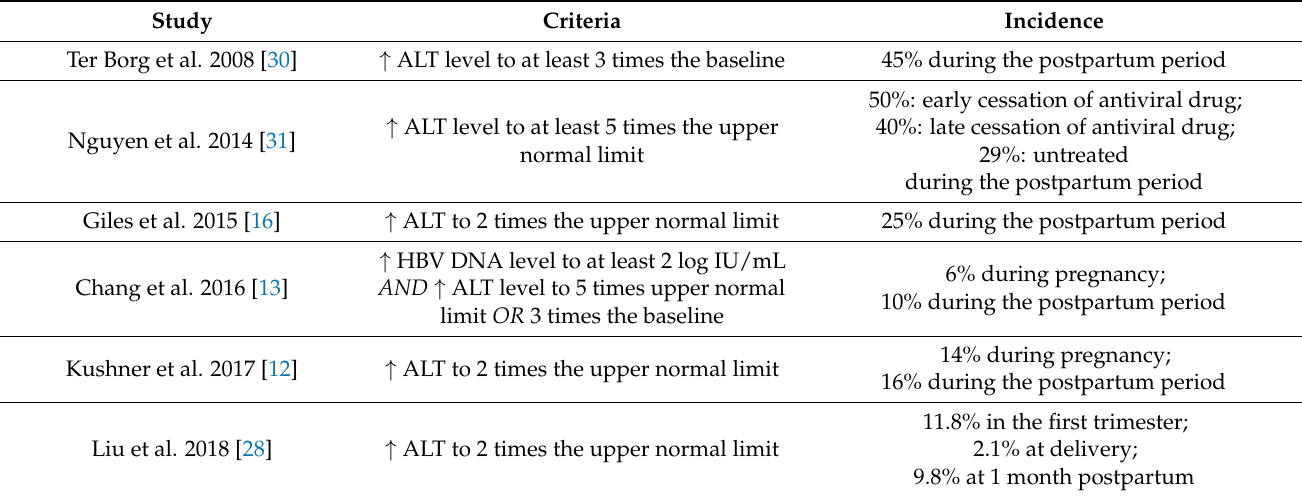
Table 1. Diagnostic criteria and incidence of hepatitis flare from various studies. Criteria